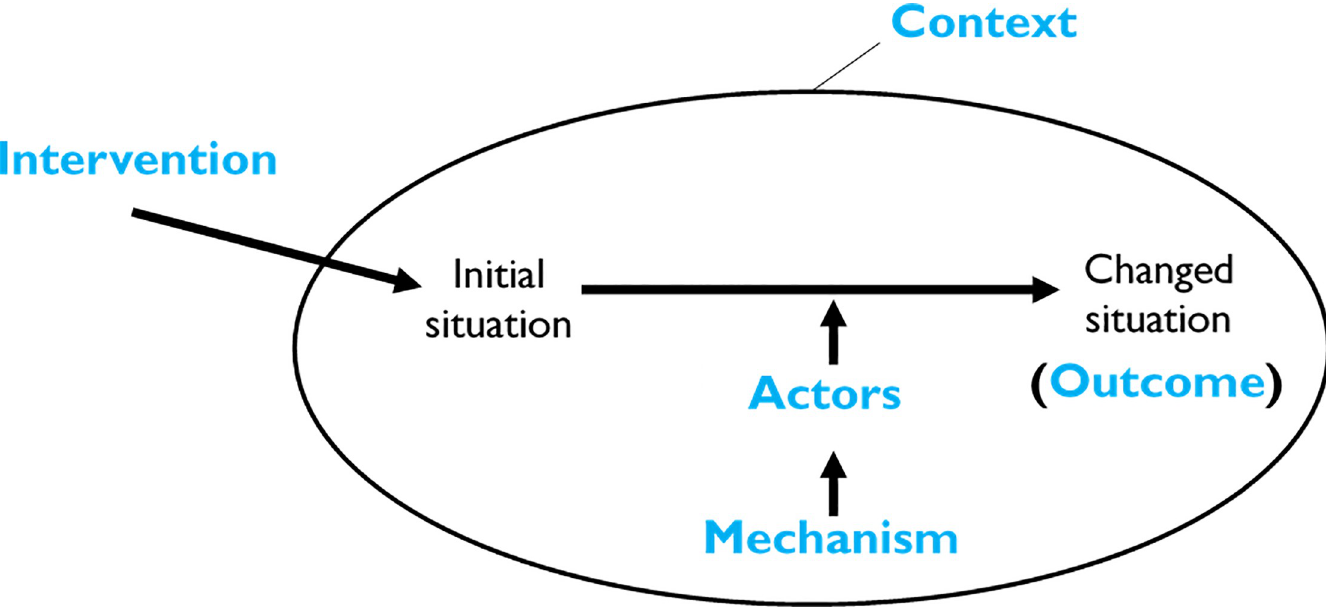
Fig 1. The ICAMO